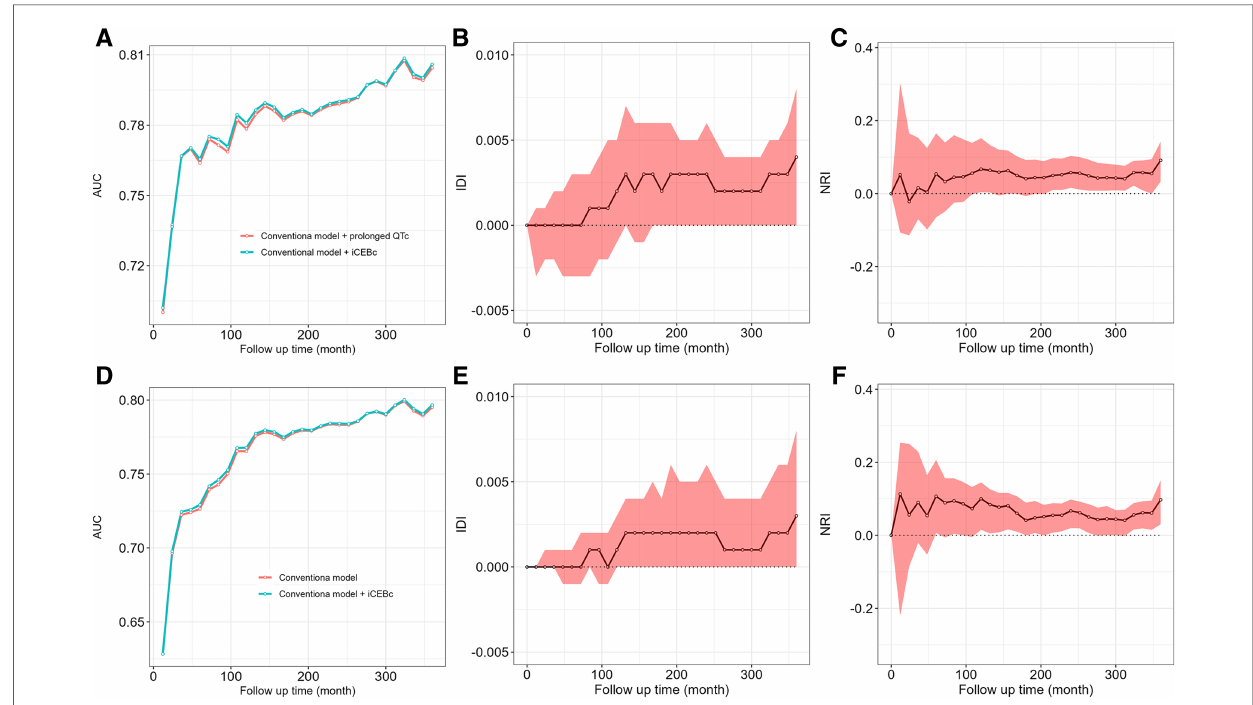
FIGURE 4 The comparison of AUC, IDI, NRI between conventional model adding iCEBc and conventional model adding prolonged QTc interval. A – C showed the complete study population. D – F showed the group with normal QTc interval. AUC, area under curve; IDI, integrated discrimination index; NRI, net reclassi fi cation